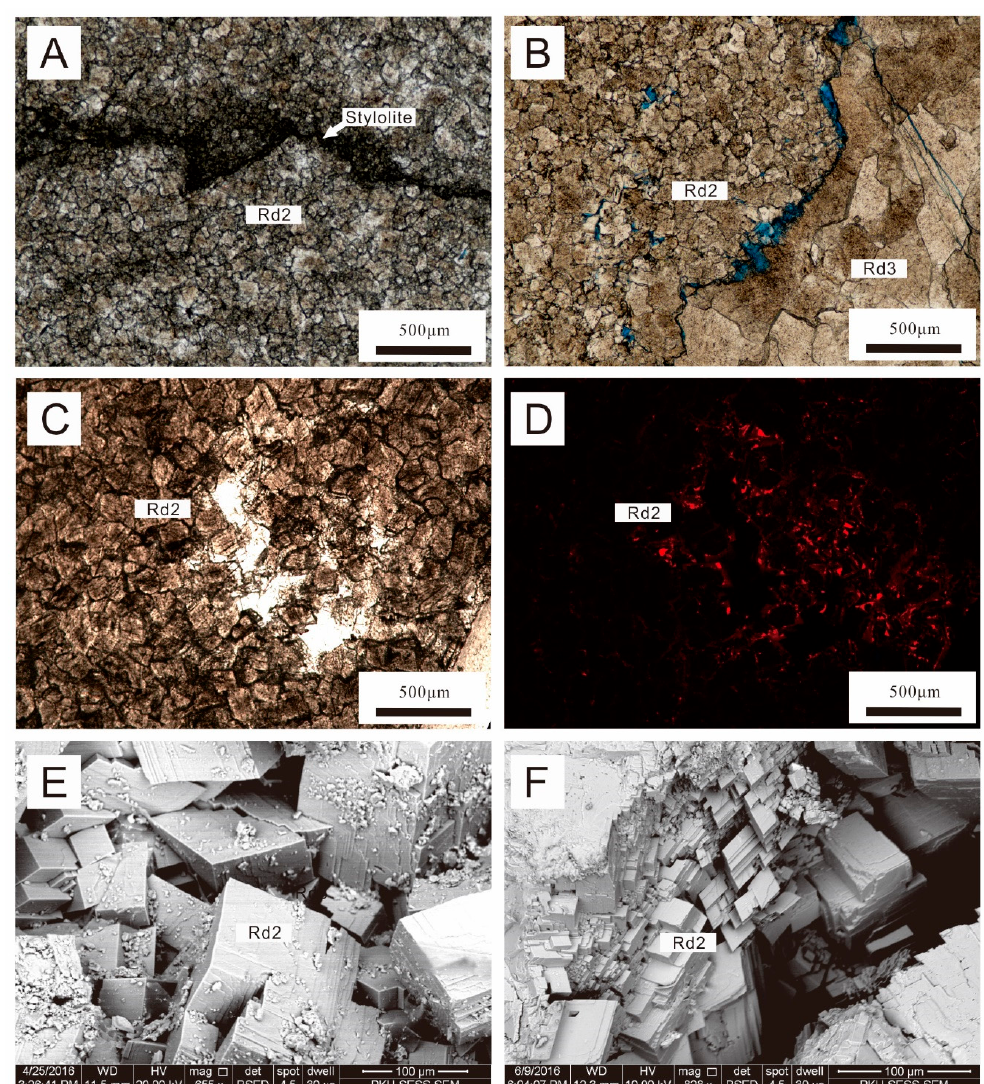
Figure 5. Rd2 dolomite. ( A ) Photomicrograph of planar euhedral to subhedral Rd2 dolomite crystals cut by stylolite (Xinjigu; P 2 q ); ( B ) portion of euhedral to subhedral Rd2 dolomite recrystallized to Rd3 dolomite with curved crystals, showing different sizes and shapes (Xinjigu; P 2 q ); ( C ) euhedral to subhedral crystals had a cloudy core surrounded by a clear rim (Xinjigu; P 2 m ); ( D ) cathodoluminescence (CL) photomicrograph of ( C ) exhibiting Rd2 dolomite displayed very dull luminescence, but the crystals close to vugs showed bright-red rims (Xinjigu; P 2 m ); ( E , F ) photomicrograph (SEM) exhibiting fine Rd2 dolomite crystals showing coarser crystals in vugs (Xinjigu; P 2 q